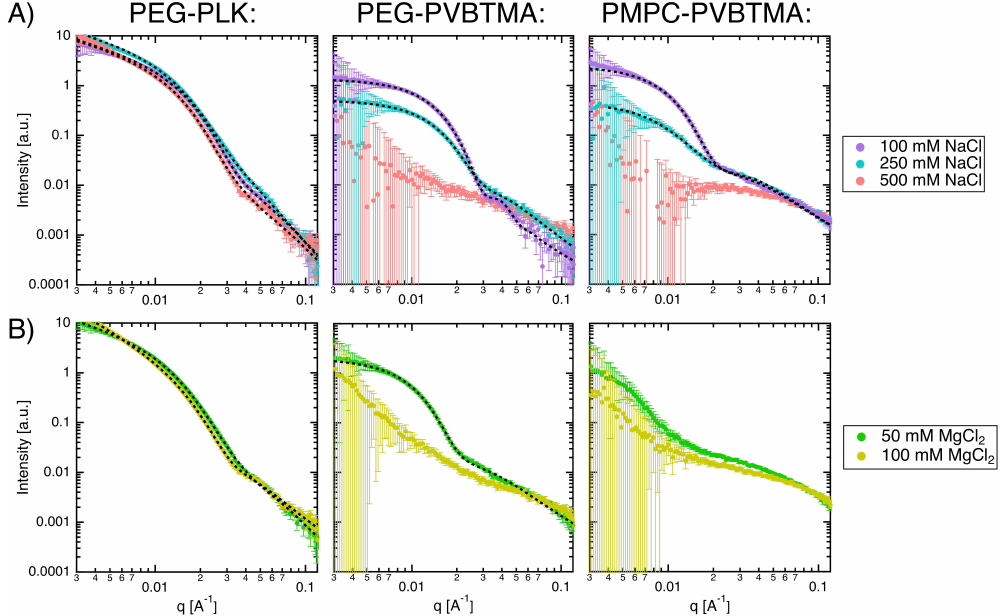
Figure 6. Small angle X-ray scattering data (color) and fits (black) for neutral 10k -charged 100 micelles in a range of ( A ) NaCl and ( B ) MgCl 2 concentrations. PEG 10K -PLK 93 / PAA 50 micelles are most resistant to salt, followed by PEG 10K -PVBTMA 100 / PAA 50 , then PMPC 10K -PVBTMA 97 / PAA 50 . Data are not scaled for this figure to show decreasing intensity with added